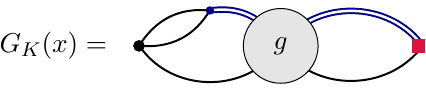
Figure 3 . Contributions to the two-point function G K ( x ) . The single and double lines denote the particle propagator and the full dimer propagator, respectively. The quantity T stands for the particle-dimer scattering amplitude. The difference between G G ( x − y ) , shown in figure 2, boils down to the different sink operators used (these correspond to the utmost right vertices in the pertinent